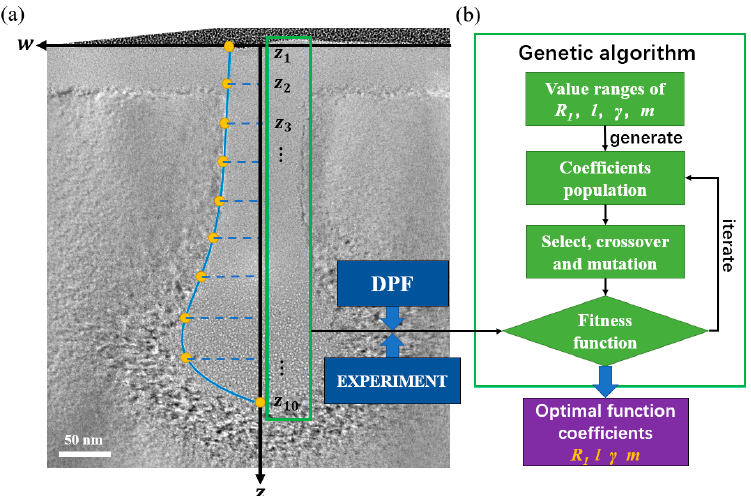
Figure 5. Process of genetic algorithm to solve DPF coefficients: ( a ) Coordinate system of the amorphous damage profile and the profile feature points; ( b ) Diagram of genetic algorithm to solve DPF coefficients. The profile feature points were implanted into the fitness evaluation as a reference